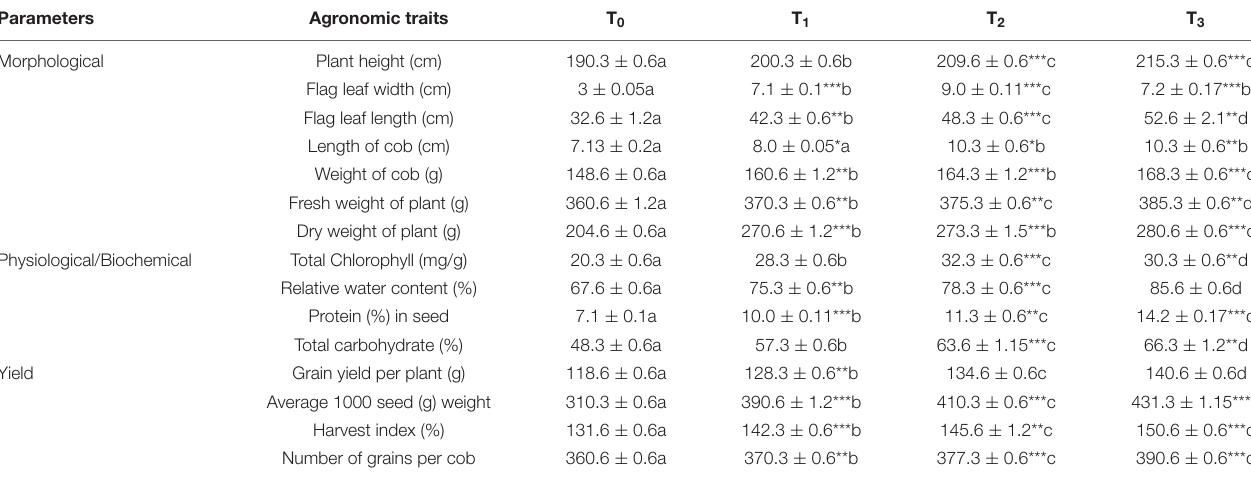
TABLE 7 | Effect of Azotobacter nigricans (KP966496; PR19 ) on morphological and yield parameters of maize var. SHIATS MS-2.